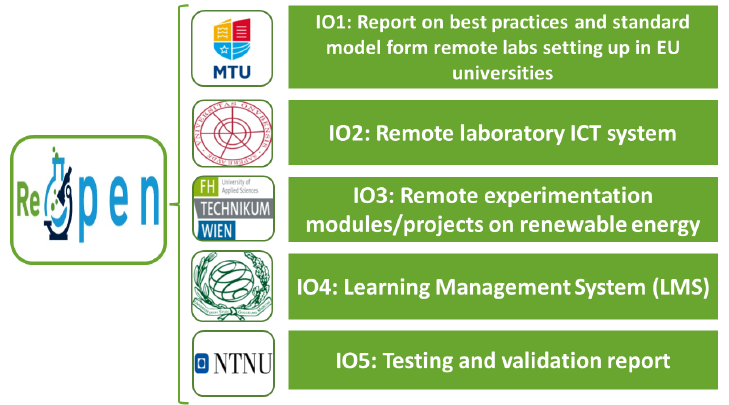
Figure 2. Intellectual outputs (IOs) of each European university.